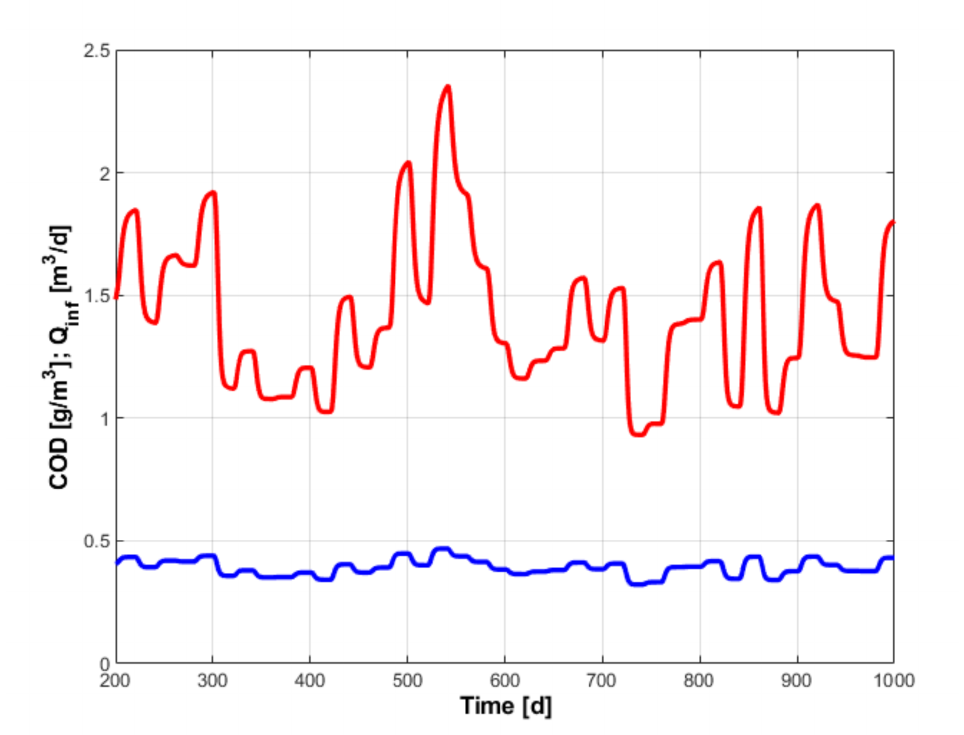
Figure 2. Input (blue) and output (red) data collected by process simulation using the ADM1